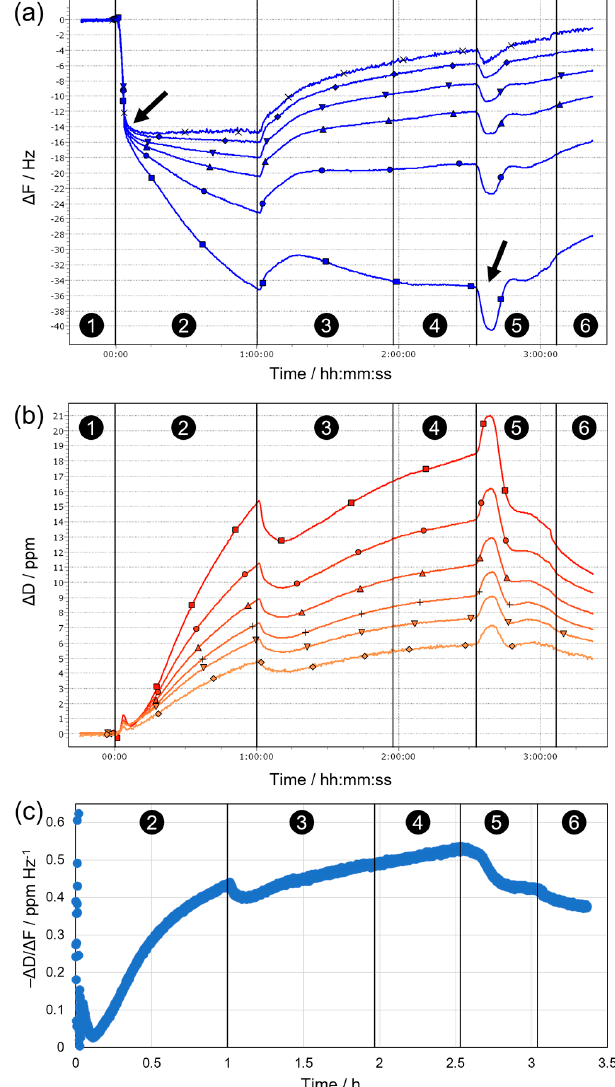
Figure 8. Effects of surfactants and enzymes on fixed P. fluorescens biofilms, as monitored in situ by QCM. ( a , b ) Time-dependent changes of ( a ) frequency and ( b ) dissipation during sequential incubation of a fixed biofilm (immobilized on a gold-coated QCM sensor) with (1) hard water, (2) detergent in hard water (F1), (3) enzymes and detergent in hard water (F1/2), (4) detergent in hard water (F1), (5) hard water, and (6) deionized water, shown in an exemplary result of 2 independent QCM measurements of separate QCM sensors with fixed biofilms. Arrows indicate initial dip in ∆ F after ca. 3 min and second prominent dip after 2.5 h. For both ∆ F and ∆ D, signals from different overtones (n) of the main resonance are shown (squares: n = 3, circles: n = 5, triangles: n = 7, inverted triangles: n = 9, diamonds: n = 11, crosses: n = 13). ( c ) Plot of the ratio of dissipation and frequency changes over time for the third overtone, representing a measure for the mass-normalized softening of the biofilm surface.